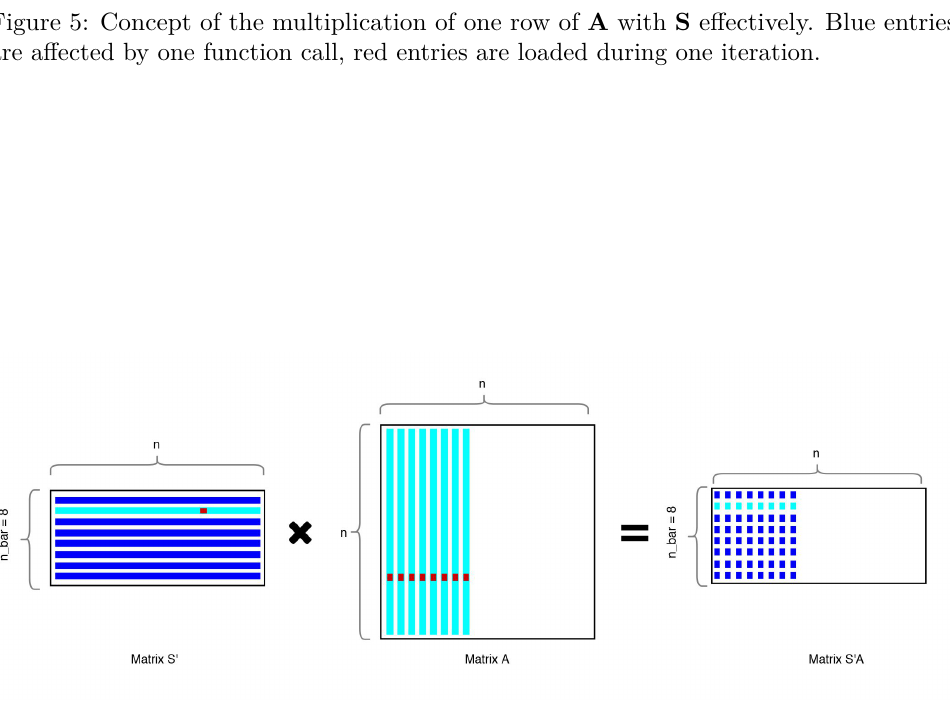
Figure 6: Concept of the multiplication of 8 columns of A with S 0 effectively. Blue and light blue entries are affected by one function call, light blue entries are loaded by one entire loop, red entries are loaded during one